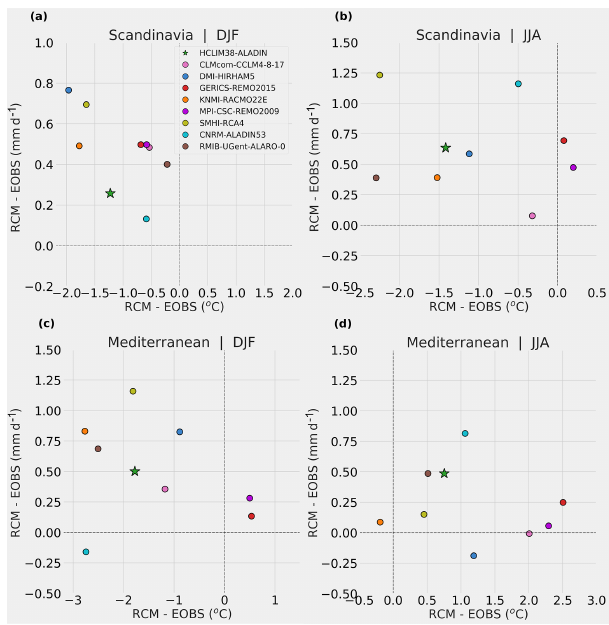
Figure 2. Difference between RCMs and E-OBS of near-surface temperature ( x axis) and daily precipitation ( y axis) for (a, c) DJF and (b, d) JJA averaged over 1999–2008 for two PRUDENCE Eu- ropean subregions: (a, b) Scandinavia and (c, d) the